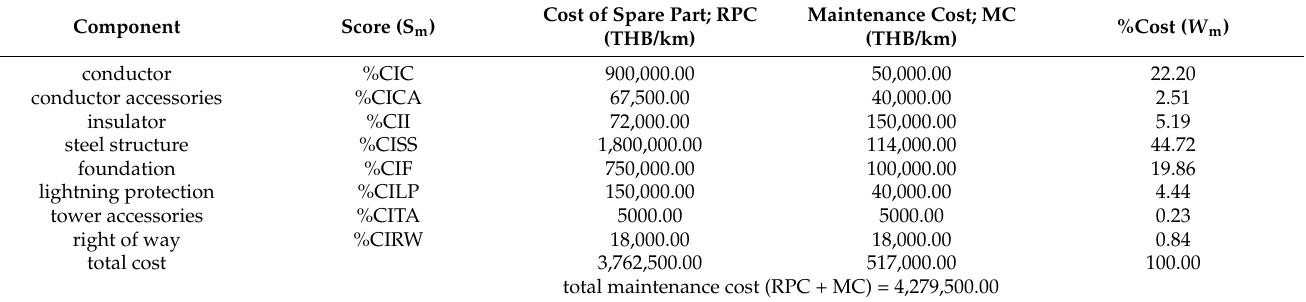
Table 5. Maintenance cost of 230 kV #1, double circuit, and 1 × 1272 MCM ACSR/GA.